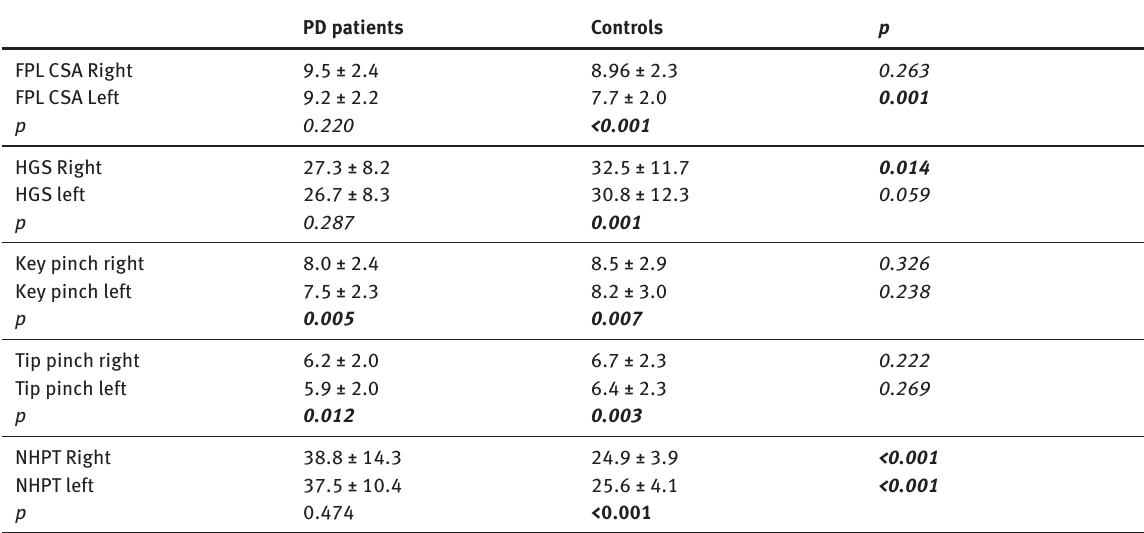
FPL CSA: Flexor pollicis longus tendon cross sectional area, HGS: Hand grip strength, NHPT: Nine Hole Peg